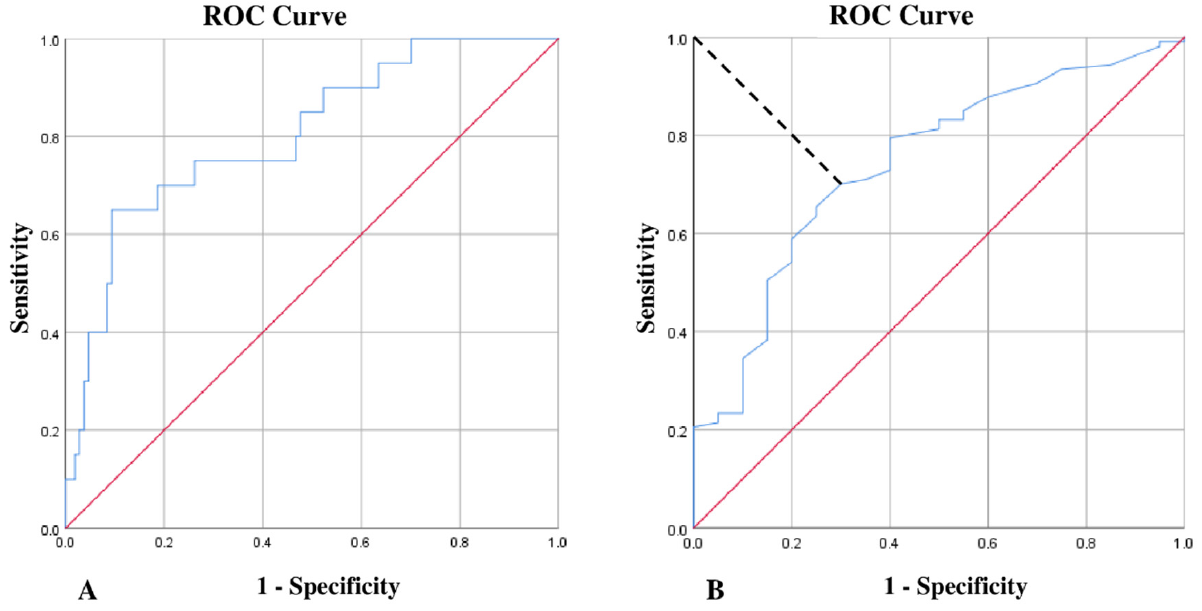
Figure 2. Panel ( A ): ROC curve analysis of the logistic regression model of HDL-C association with in-hospital mortality, adjusted for age and comorbidities (see Table 2). Area under the ROC curve: 0.804, 95% CI 0.698–0.910, p < 0.001). Panel ( B ): ROC curve analysis of HDL-C best cut-off for hospital mortality in IE. Area under the ROC curve: 0.743, 95% CI 0.628–0.857; p = 0.001). HDL-C levels were also significantly lower in IE patients who experienced septic embolic events (median 24 vs. 30 mg/dL in those without embolism; p = 0.036; Supplementary Table S2, Figure 1). Prediction of IE complicated by embolism was further increased by combining evaluation of higher CRP levels and lower HDL-C levels (Supplementary Table